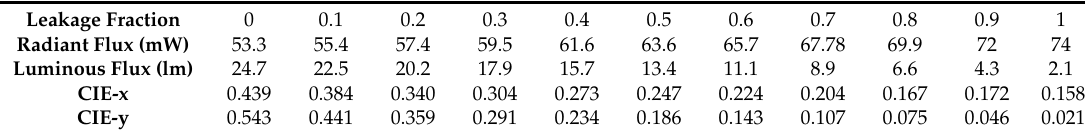
Table 1. Calculated results for different leakage